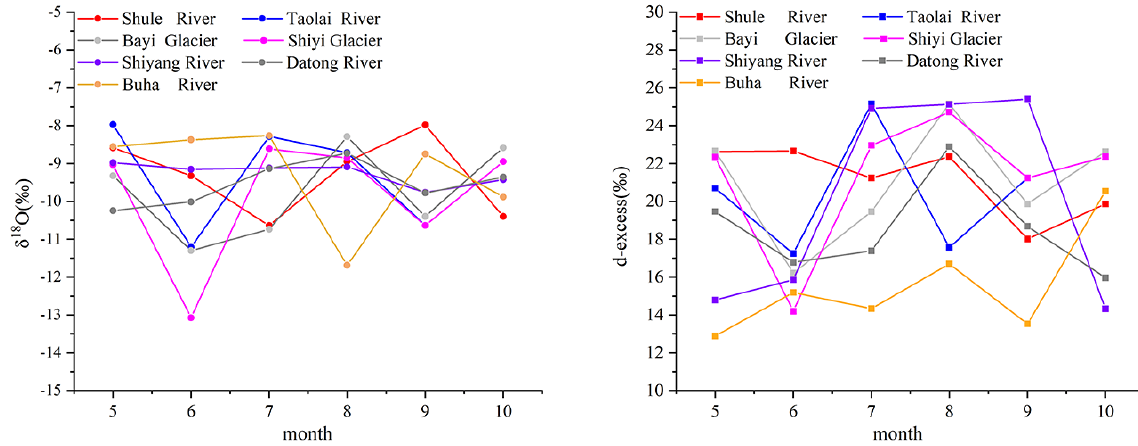
Figure 3. Temporal variation of stable isotopes in glacier and snow meltwater in the Qilian